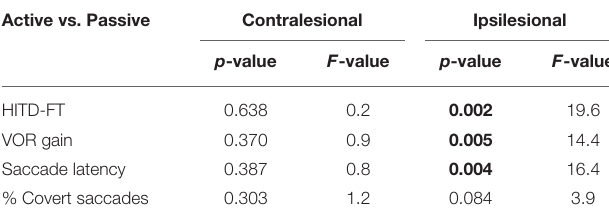
TABLE 3 | Repeated measures GLM-ANOVA analyses of the performance during active vs. passive head-impulses when the head movements were performed in ipsilesional and contralesional